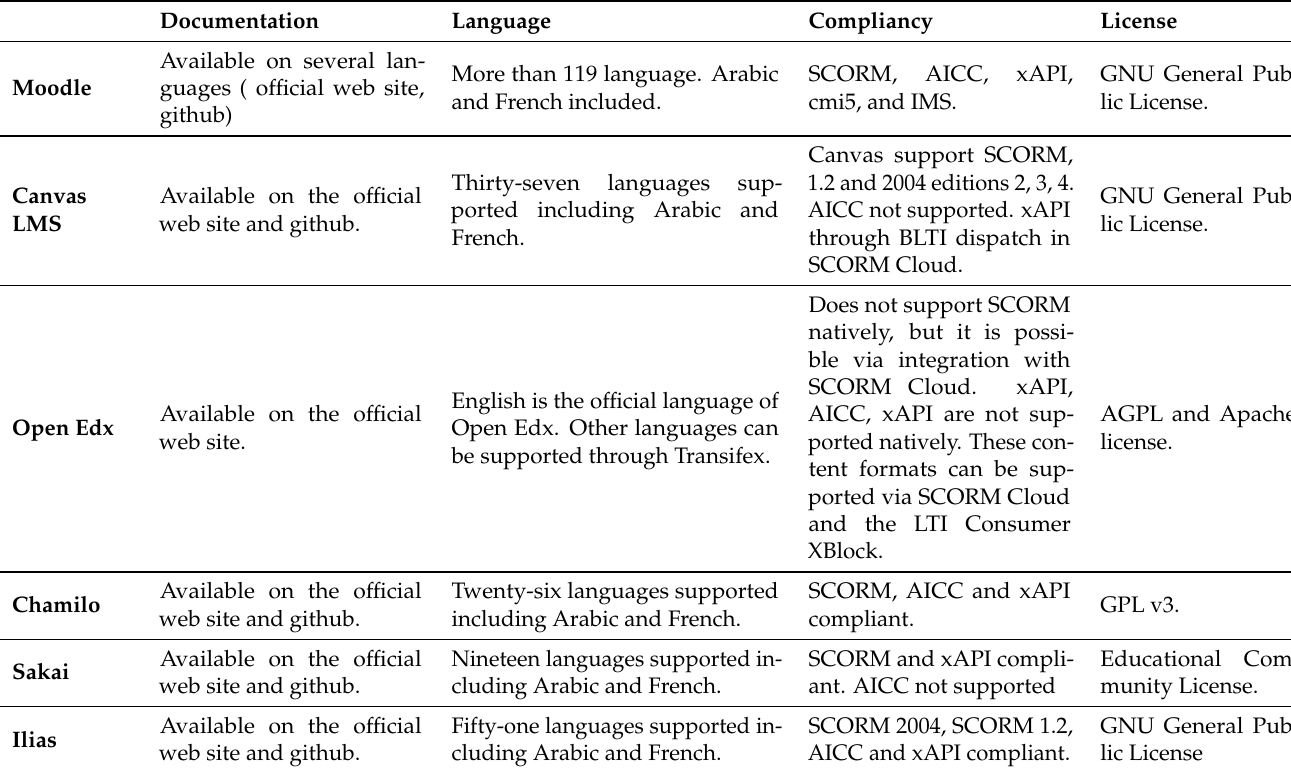
Table 5. Comparison of six open source eLearning